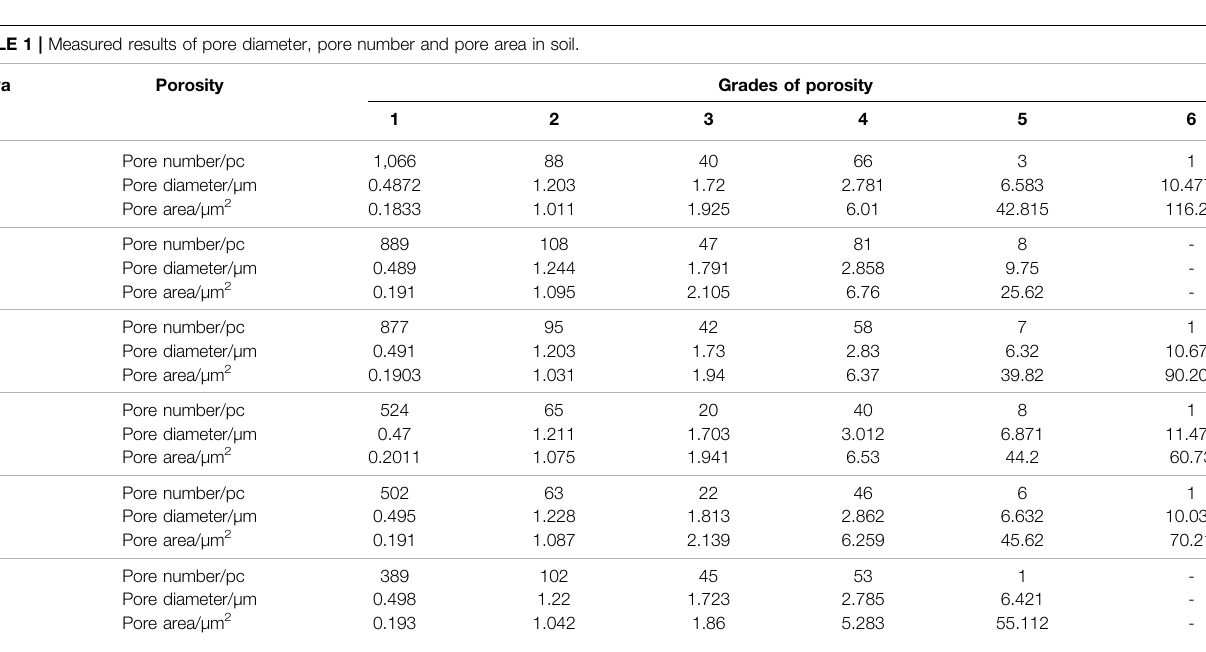
TABLE 1 | Measured results of pore diameter, pore number and pore area in